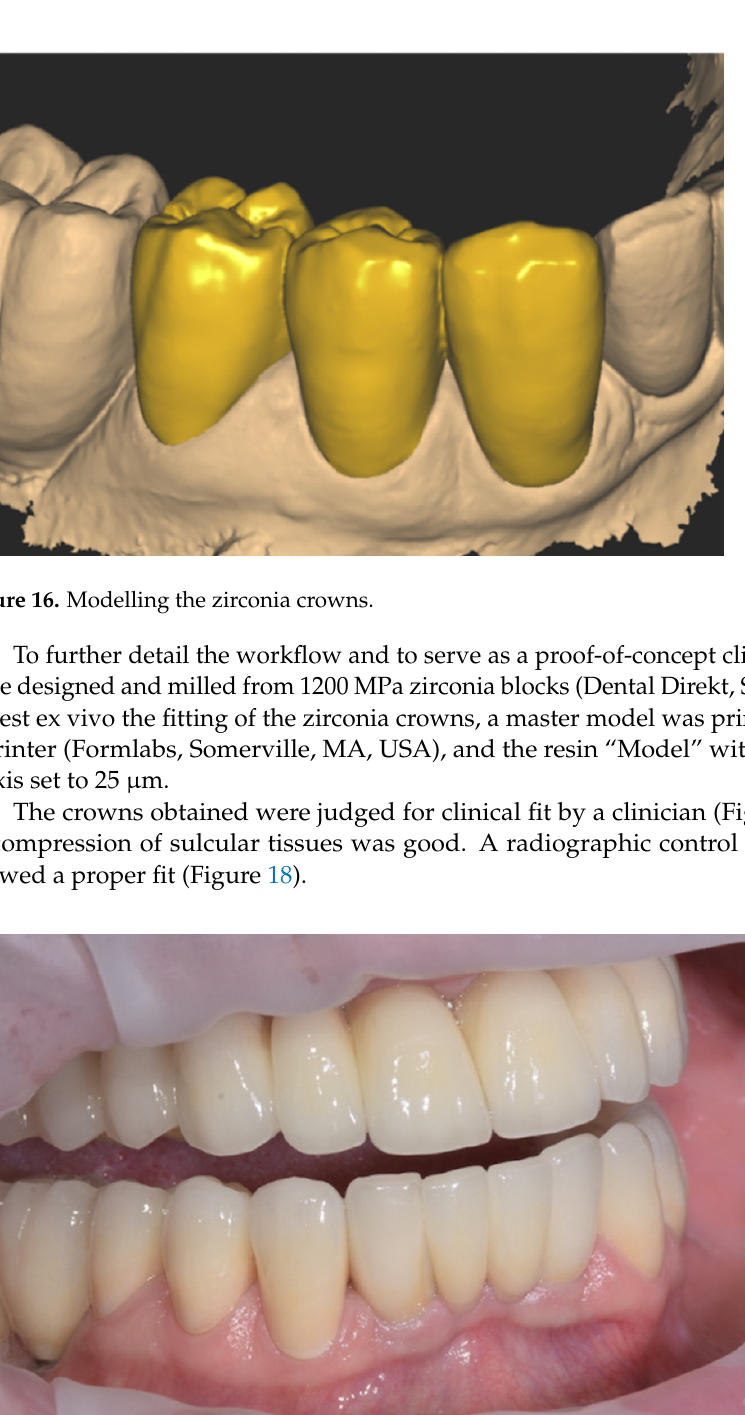
Figure 15. Substitution of the digital abutments on the master model.